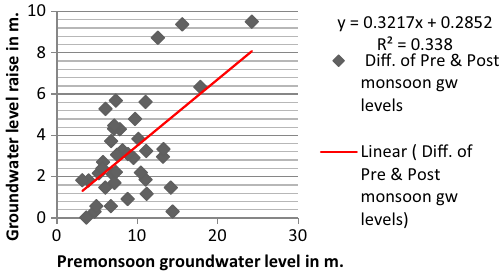
y = 0.3217x + 0.2852 R² = 0.338